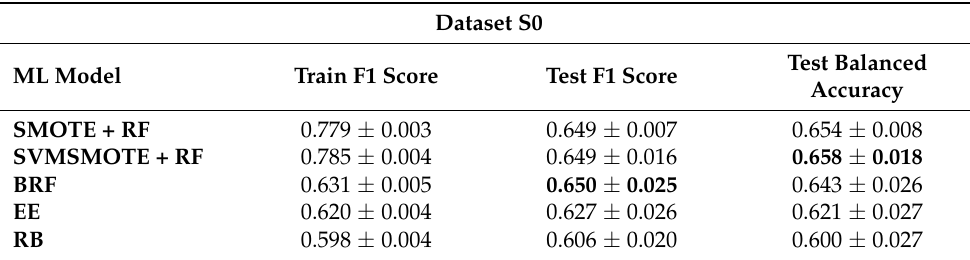
Table 3. Global evaluation metrics for each learning model built with the information at the time of enrollment (dataset S0). Values represent mean and standard deviation.